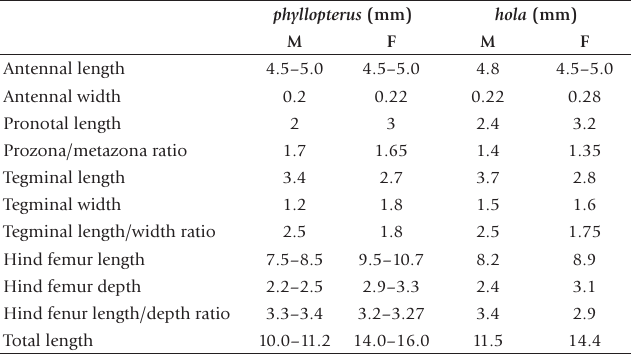
Table 10. Measurements of Brachybothrus